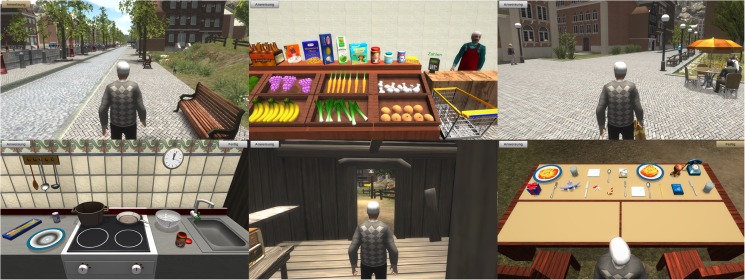
Screen shots of the six virtual tasks.(A) The navigation task “Go to the shop”, (B) The shopping task, (C) The navigation task “Go back home”, (D) The cooking task, (E) The navigation task “Go to the garden”, (F) The table preparation task.